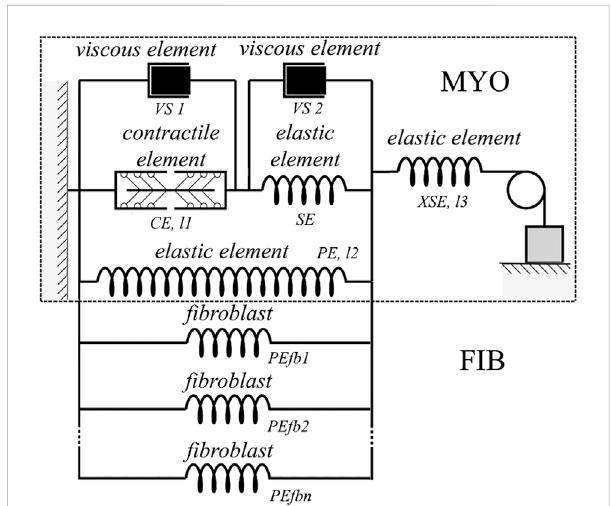
FIGURE 2 Rheological scheme of the virtual cardiomyocyte described with the TP + M model (delimited by dashed rectangular box) linked with the elastic units re fl ecting fi broblast mechanics. The virtual cardiomyocyte consists of a contractile element generating an active force, three elastic elements, and two viscous elements. The contractile element in the model reproduces the sarcomeres in the cardiomyocyte. Fibroblasts (PEfb1, PEfb2, ..., PEfbn) are attached in parallel to the elastic element ( PE ) of the cardiomyocyte, where n is the number of fi broblasts